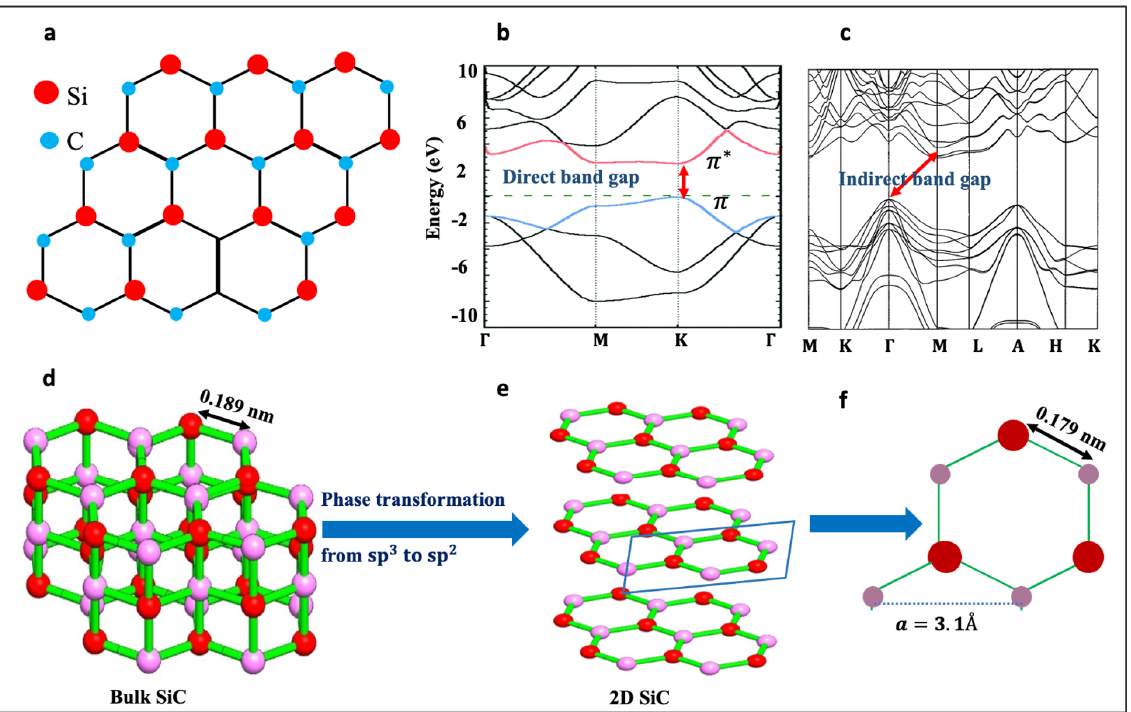
Figure 1. ( a ) The chemical structure of monolayer SiC, ( b ) Electronic band structures of 2D SiC, and bulk 6H-SiC, respectively. Republished from [22] with the permission of RSC. Figure 1c. ( c ) Electronic band structures of 6H-SiC. Reproduced from [31] with the permission of AIP publishing. ( d , e ) a schematic of phase transformation in 2D SiC. ( f ) a schematic of the unit cell of 2D SiC, showing the in-plane lattice constant, a, and atomic bonding of 2D